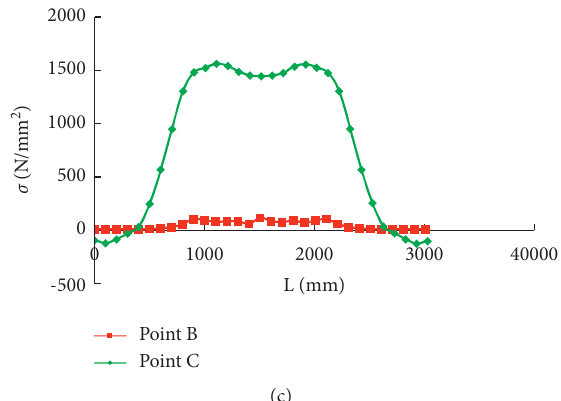
Figure 6: Section stress distribution along the beam length: (a) section of concrete, (b) section of steel reinforcements, and (c) section of CFRP strips.